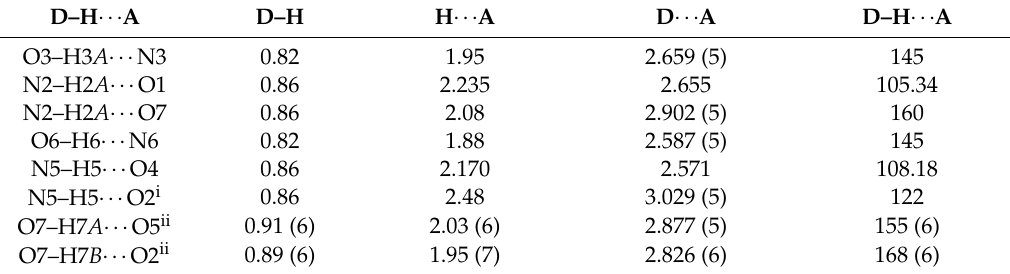
Figure 5. Cyclic Face-to-face stacking interaction between various rings in the crystal packing. Distances shown are in Å with H-atoms omitted for clarity.